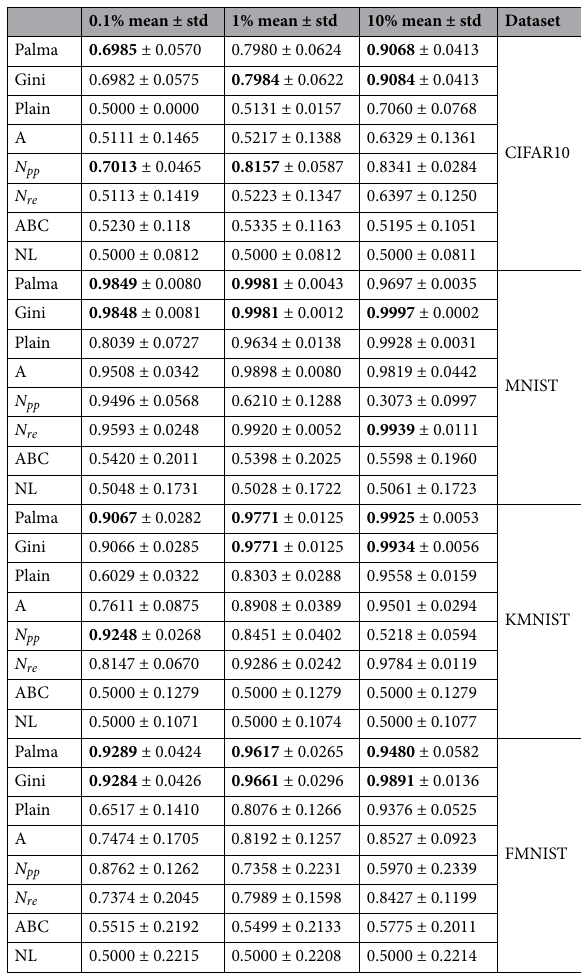
Table 3. AUROCs for diverse inlier setup (fractions 0.1%, 1% and 10%). The best and the second- best results are in